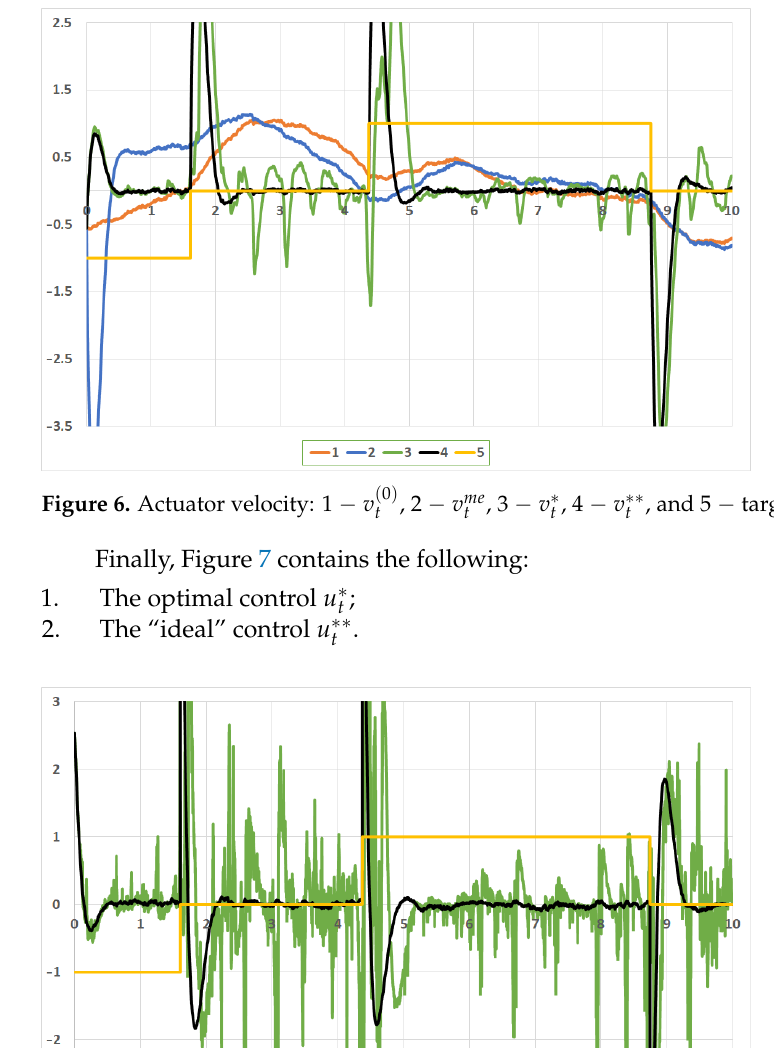
Figure 7. Controls: 1 − u ∗